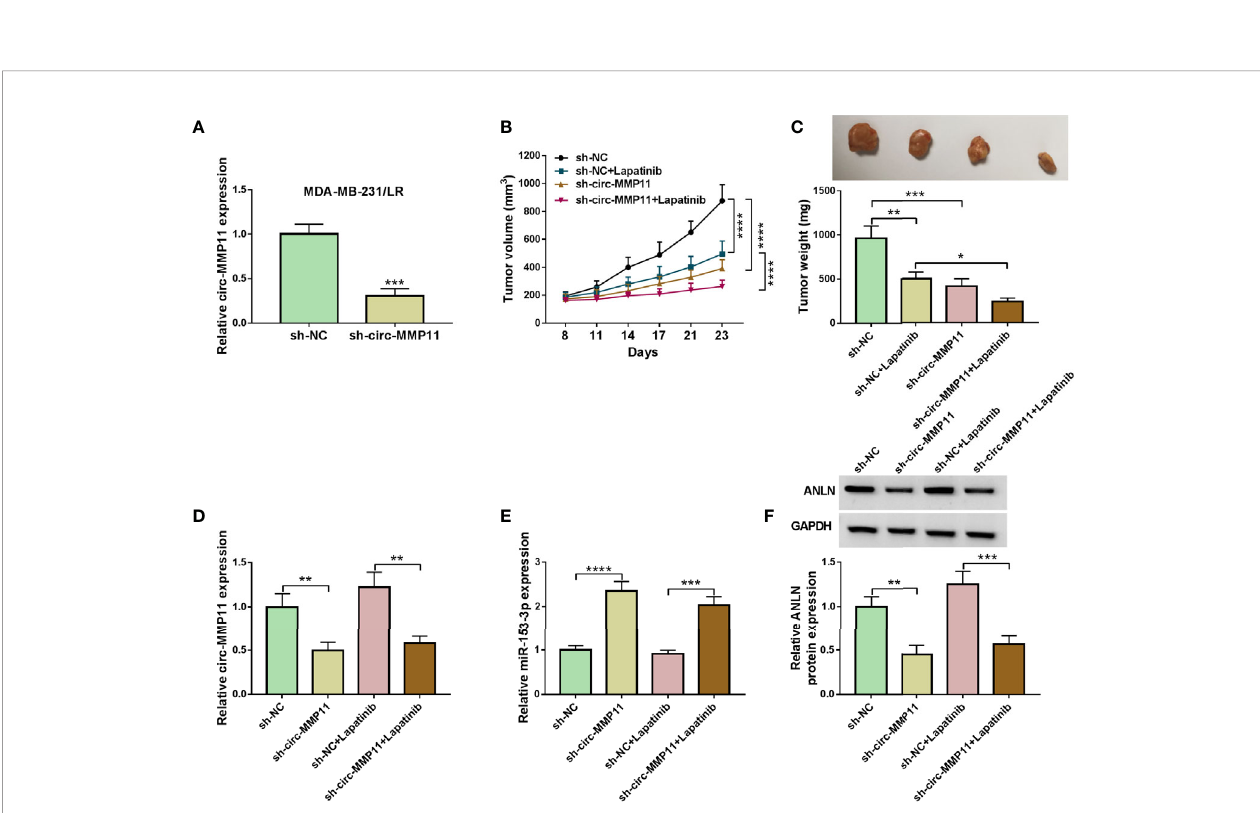
FIGURE 9 | Circ-MMP11 de fi ciency suppressed tumor growth and improved lapatinib sensitivity in vivo . (A) RT-qPCR assay was used to determine circ-MMP11 expression in sh-circ-MMP11or sh-NC-introduced MDA-MB-231/LR cells. (B, C) Tumor volume and tumor weight were detected in xenografts. (D) The expression level of circ-MMP11 was examined in xenografts. (E, F) miR-153-3p and ANLN level were detected by RT-qPCR assay and western blot assay in this xenograft. * P < 0.05, ** P < 0.01, *** P < 0.001, **** P < 0.0001 (Student ’ s t -test or ANOVA with Tukey ’ s tests), circ-MMP11 relative to GAPDH, miR-153-3p relative to U6, ANLN relative to GAPDH.